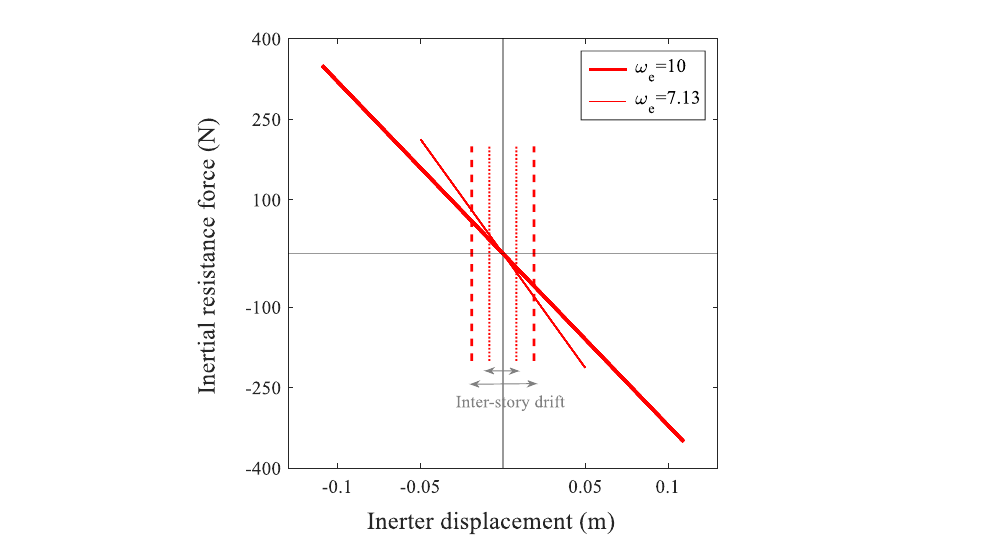
Figure 12. ATMID inertial force-displacement correlation curve at frequencies of 10 and 7.13 (rad/s).